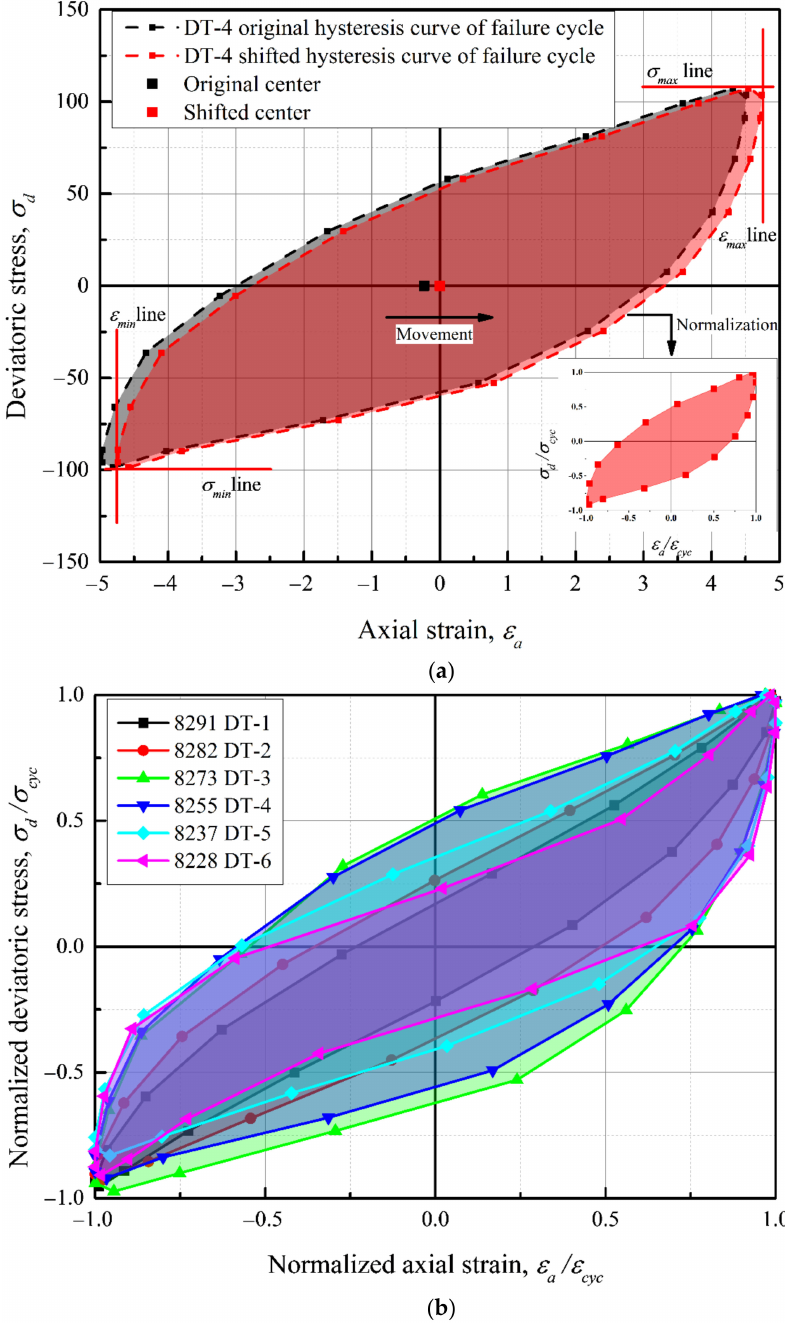
Figure 10. Double-normalized hysteresis curve of failure (or terminate) cycle: ( a ) Schematic diagram of normalization; ( b ) Double-normalized hysteresis curve of failure (or terminate) cycle for the mineral composition of artificial marine